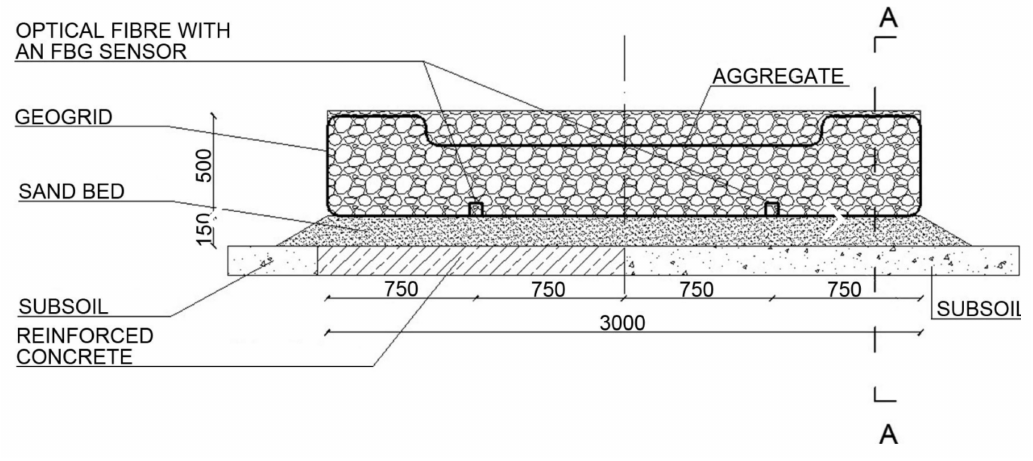
Figure 4. Diagram of test stand 1